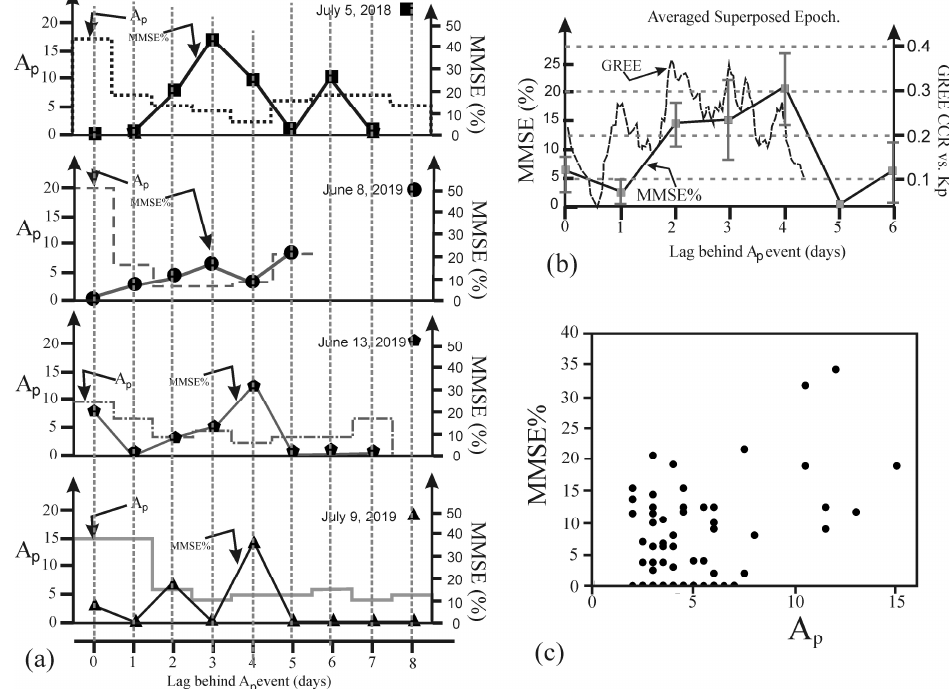
Figure 8. ( a ) Superposed epoch plots of the daily data for 4 events with A p > 8. A p is presented as a “histogram”-type format, while the percentage of the day that had visible MMSE (MMSE%) is shown as symbols connected by straight lines. ( b ) Average superposed epoch plots across all data-sets with A p > 8: error bars are ±1 standard error. ( c ) Scatter plot of MMSE% vs. A p for all available data. Note that in ( a ) and ( b ), daily values are used, while 2-day running means (as in Figure 7) are used in ( c ). The curve labelled “GREE” in ( b ) is discussed later in the text.